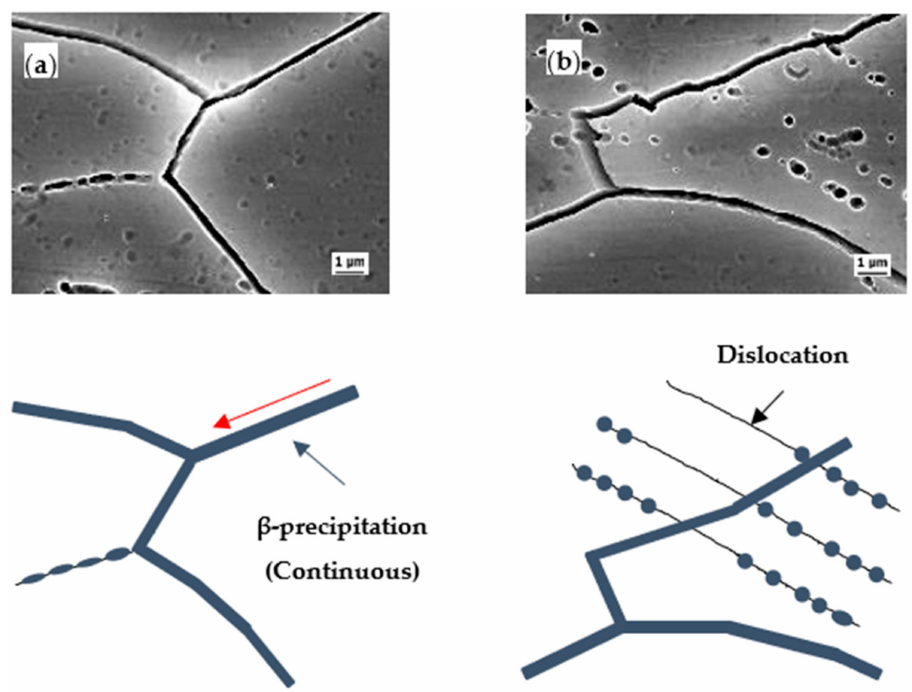
Figure 11. Close inspection of β precipitation covered grain boundary: ( a ) CR20 alloy, Sensi. 207 h, ( b ) CR50 alloy, Sensi. 207